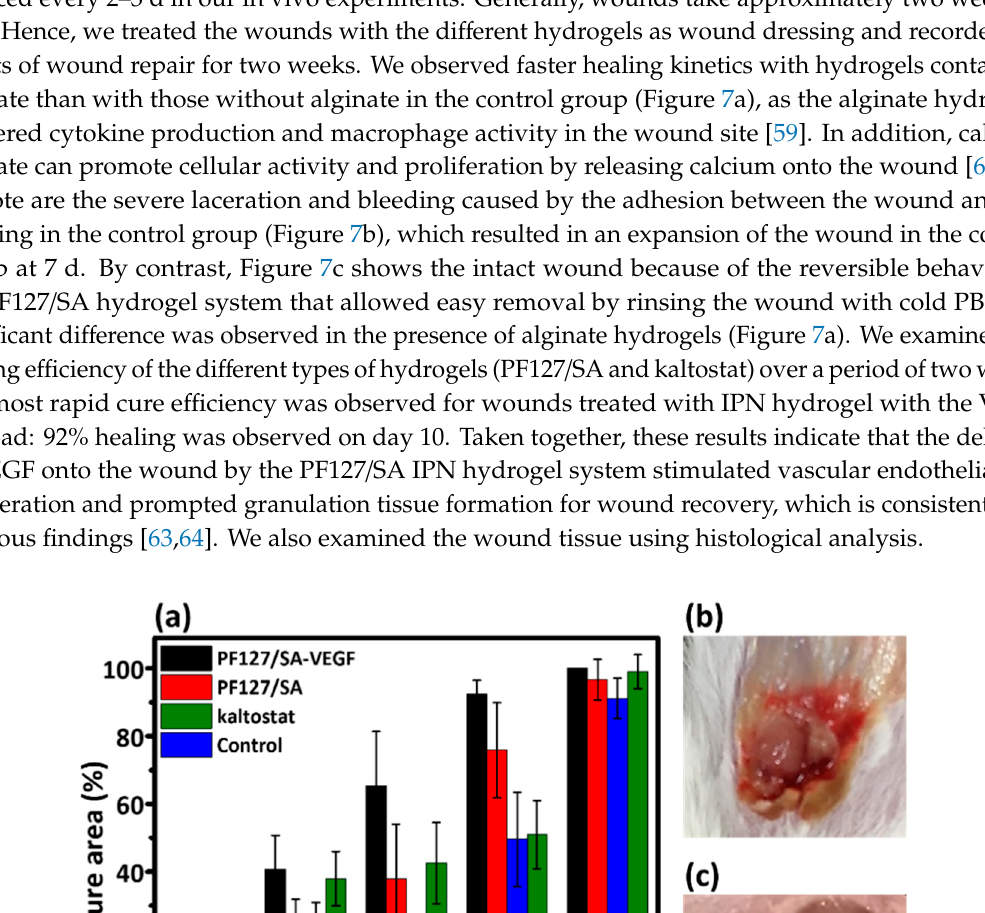
Figure 8. Photomicrographs of histological comparison between PF127/SA IPN hydrogels ( a , c ) without VEGF and ( b , d ) with VEGF for mouse wound healing. Each sample was taken after 3 d and 7 d intervals and stained with H&E (new tissue generation marked with an arrow; the red dashed line indicates thickness of the tissue). H&E, hematoxylin and eosin stain 4. Conclusions We developed a novel, reversible IPN hydrogel, composed of physical, thermosensitive networks and ionic crosslinking, and demonstrated its safety and biocompatibility. Despite the presence of sodium alginate within the PF127 hydrogels, the thermosensitive PF127 network still promoted gelation and transformed the LCST range. The introduction of calcium ions into the hydrogel resulted in the formation of a second network via ion exchange, thereby creating an elastic, layered structure in the interior and a rigid network on the exterior of the hydrogel. Additionally, we observed that with a reduction in the amount of sodium alginate in the hydrogel, even moderate